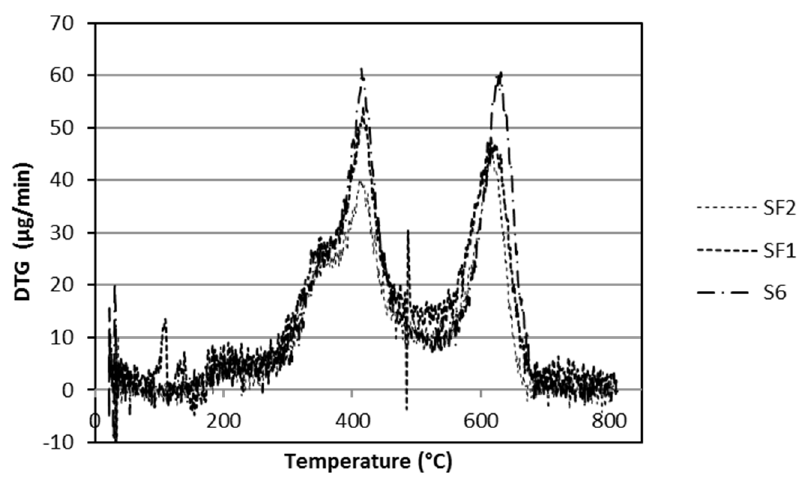
Figure 7. DTG curves of S6, SF1, and SF2 samples (not normalized).